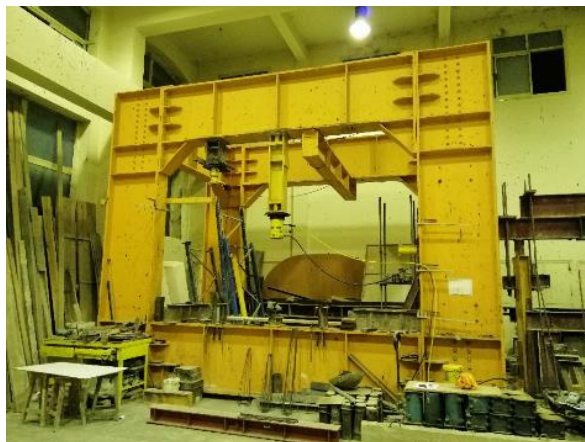
Figure 2: Test Setup